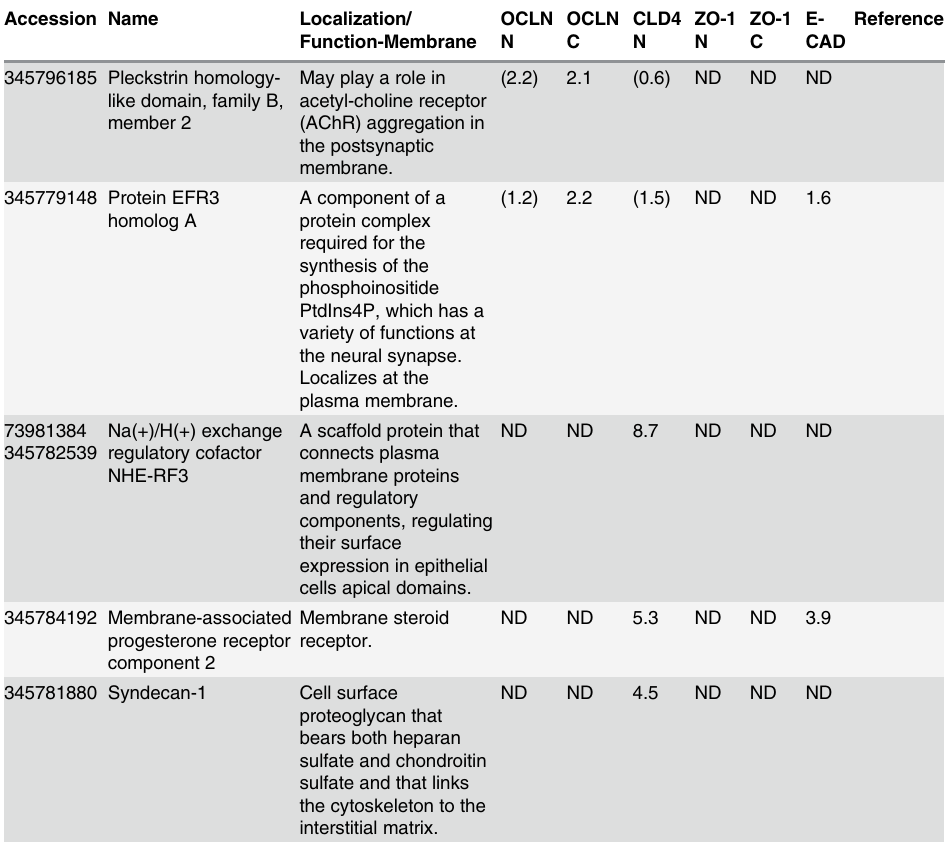
(PLLP) was highly enriched around both Ocln and Cldn4. GFP-tagged PLLP co-localizes with Ocln and Cldn4 at the TJ and along the basolateral plasma membrane in MDCK II cells (Fig. 6A, S1 Fig.). GFP-PLLP is also diffusely distributed in the cytoplasm (Fig. 6A, S1 Fig.). The trafficking protein USP6 N-terminal-like protein, also called: related to the N-terminus of tre (RNtre) was identified with mass spectrometry in the neighborhoods surrounding Ocln, Cldn4, ZO-1 and E-cad. GFP-RNtre co-localizes with both Ocln and Cldn4 at the lateral plas- ma membrane and TJ (Fig. 6B, S2 Fig.). GFP-tagged Leucine-rich repeat transmembrane pro- tein FLRT2 (FLRT2), a protein involved in cell adhesion and or receptor signaling, was localized diffusely in the cytoplasm as well as co-localized with Ocln and Cldn4 along the baso- lateral plasma membrane and the apical TJ (Fig. 6C, S3 Fig.). Rabbit antibody to MAP/micro- tubule affinity-regulating kinase 3 (Mark3), the most highly enriched kinase proximal to the N-terminus of Ocln and also enriched around Cldn4, ZO-1 and E-cad, revealed diffuse cyto- plasmic as well as distinct apical TJ staining in MDCKII cells. Mark3 was co-localized with Ocln at the apical region of the lateral cell membrane and with both Ocln and Cldn4 at the basolateral membrane below the TJ (Fig. 6D, S4